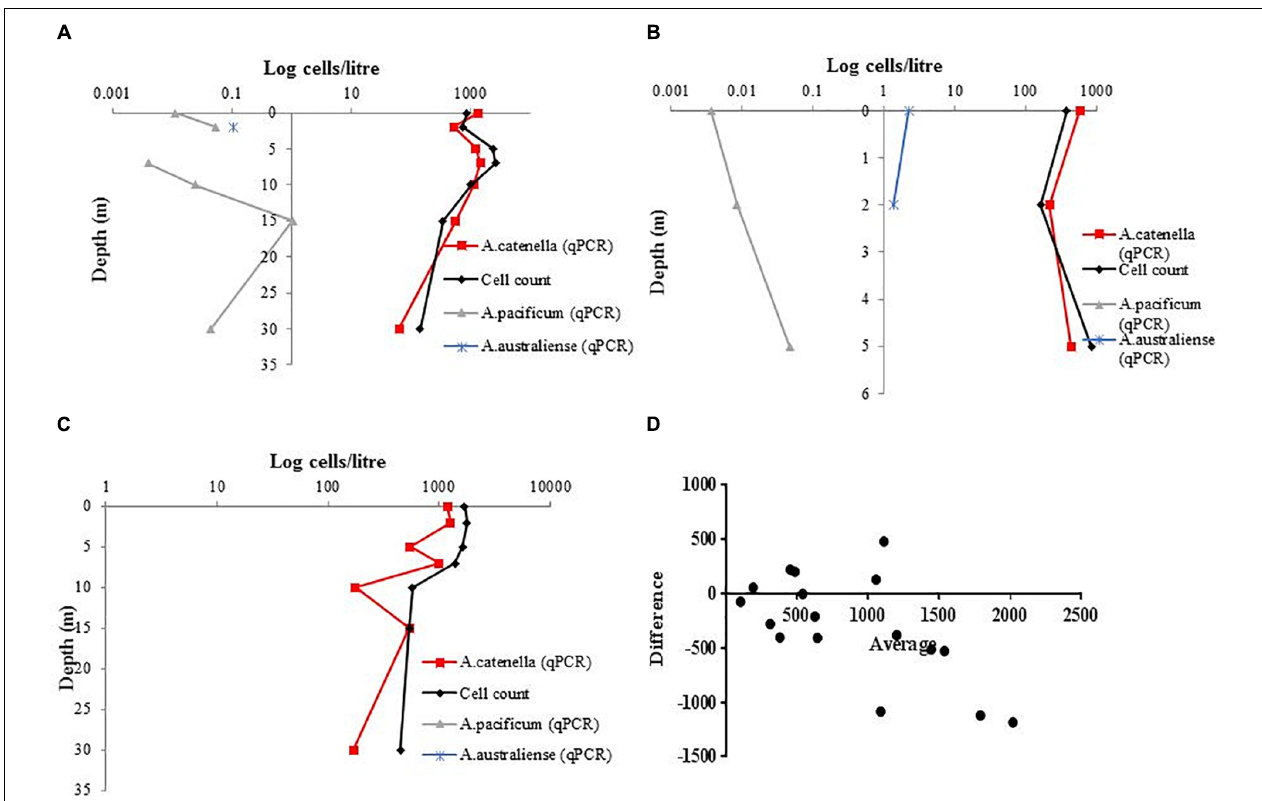
FIGURE 7 | Cross depth cell quantification using species-specific qPCR assays for A. catenella , A. pacificum , and A. australiense , in comparison with total Alexandrium count (A) . Great Oyster Bay Site 1 (B) Great Oyster Bay Site 2. (C) Spring Bay Site 3 (D) Bland-Altman measurement of agreement between species-specific A. catenella assays and light